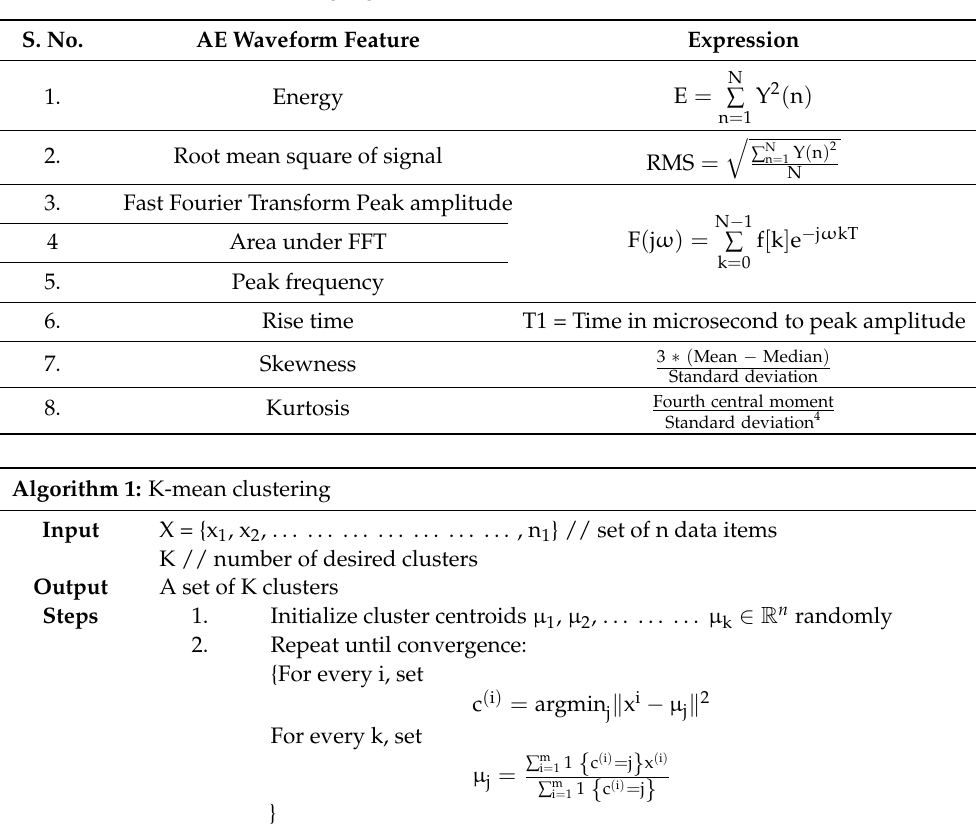
Table 1. Features for the clustering algorithm.